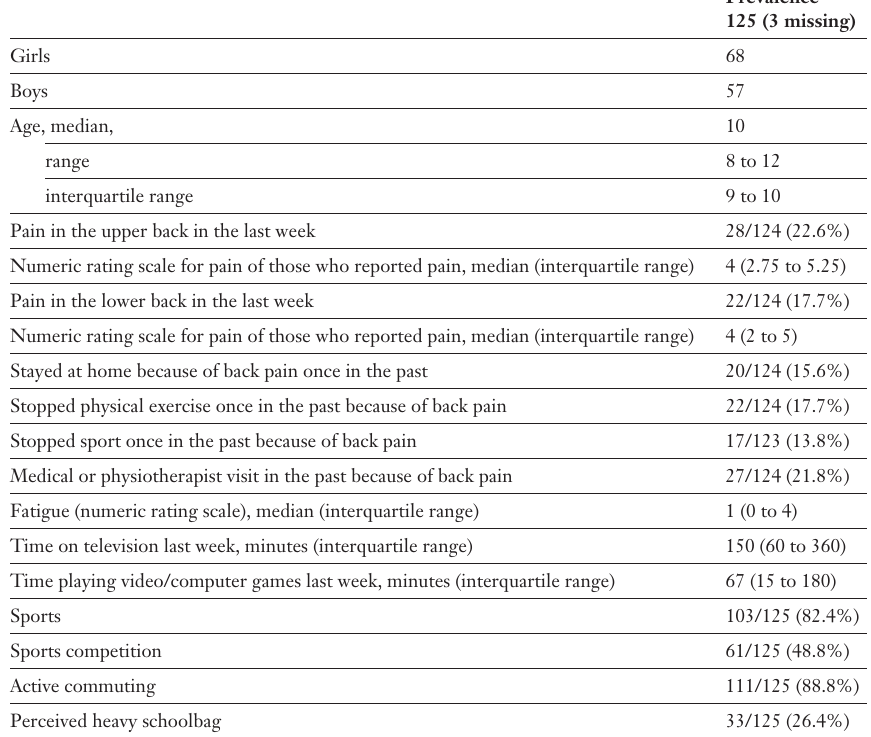
Baseline character- istics for the children